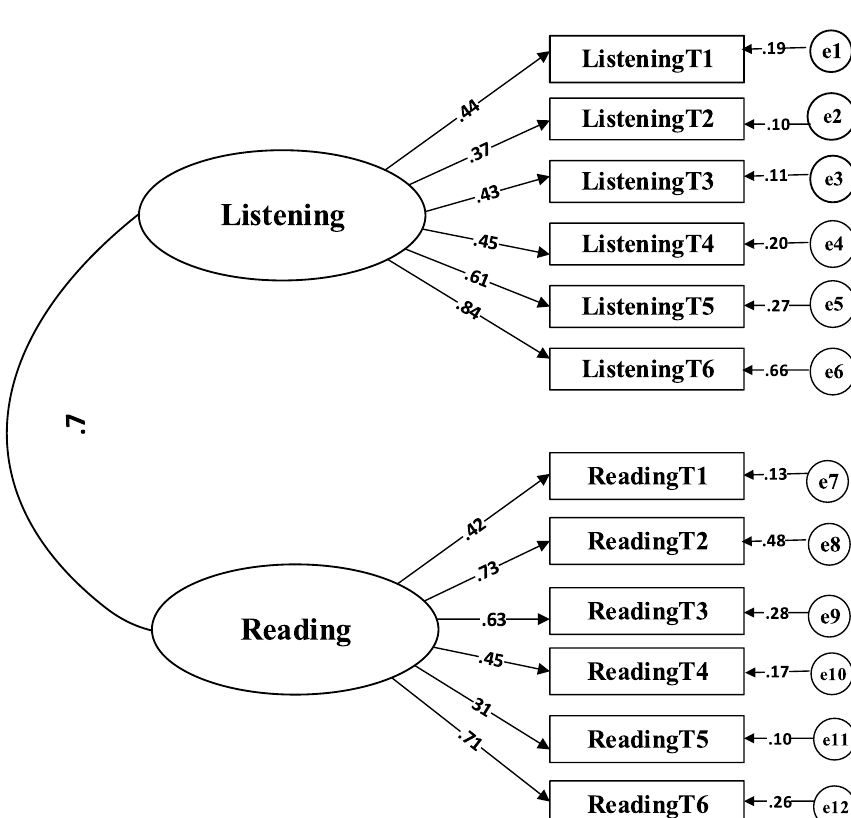
Fig. 4 Final model of correlated receptive skills. Note: All factor loadings were significant. The parameter estimates are